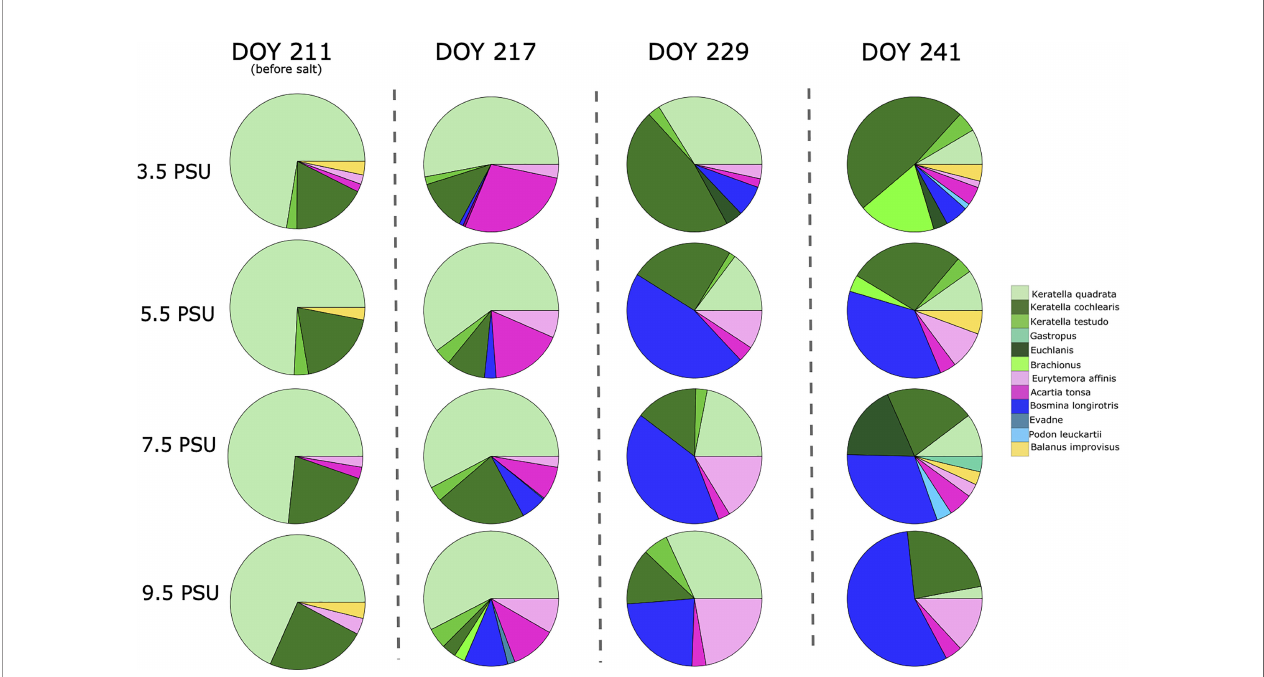
FIGURE 3 | Proportional abundance of taxa on DOY 211, 217, 229 and 241 of the experiment for all salinity treatments. Taxa under 5% abundance are excluded for simplicity. Note that DOY 211 is before salt was added to the treatments and is included to show similarity in community at the start of the